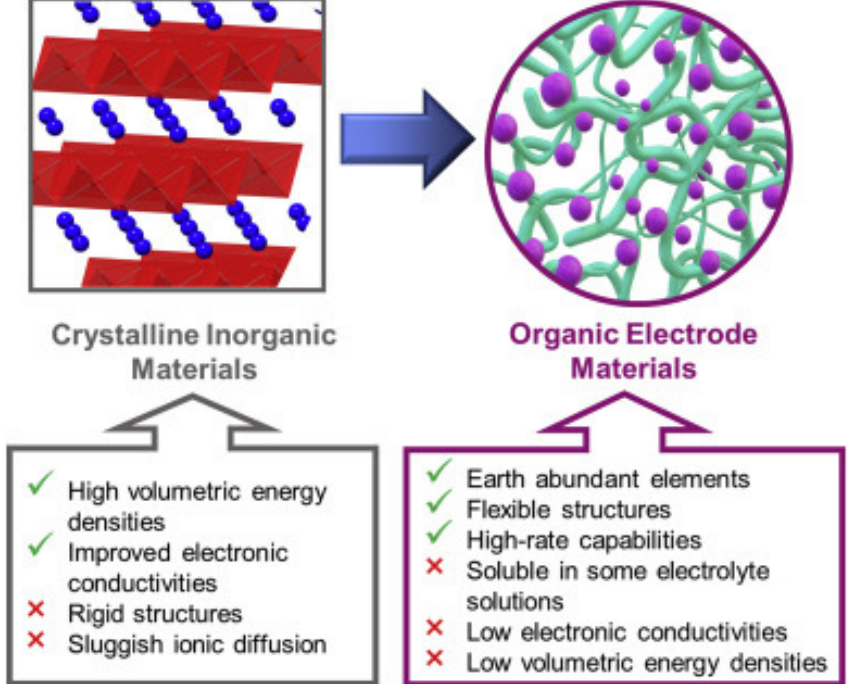
Figure 3. Schematic illustration of the unique properties of organic electrode materials which